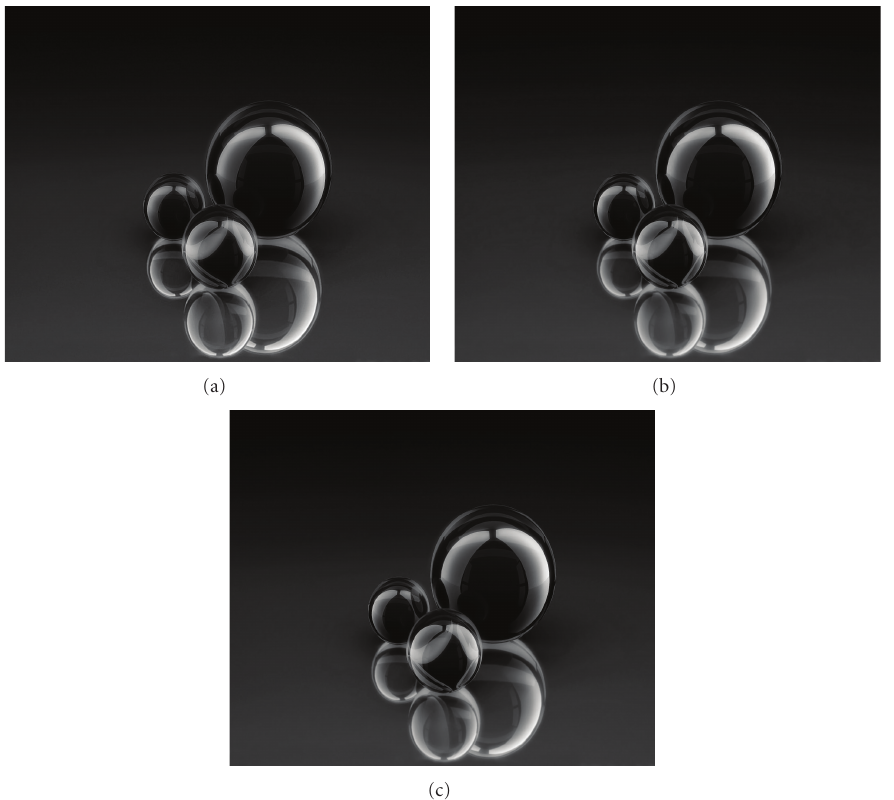
Figure 14: The SA (a), CA (b), and ESA (c) fusions of the image “Balls.” The best quality has the ESA fusion (cf. Table 2).